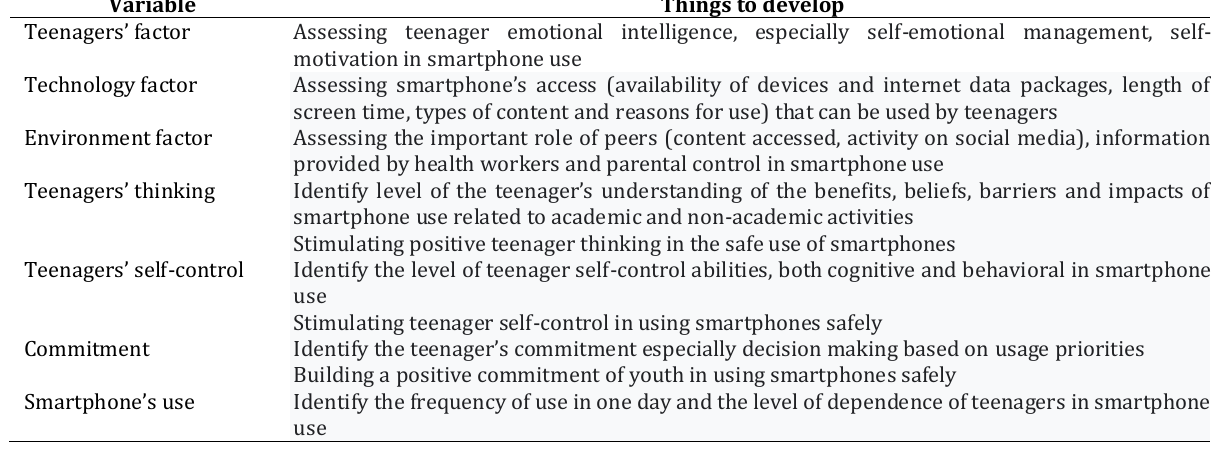
Table 6. Result of Development Model o f Teenagers’ Safety Smartphone Use